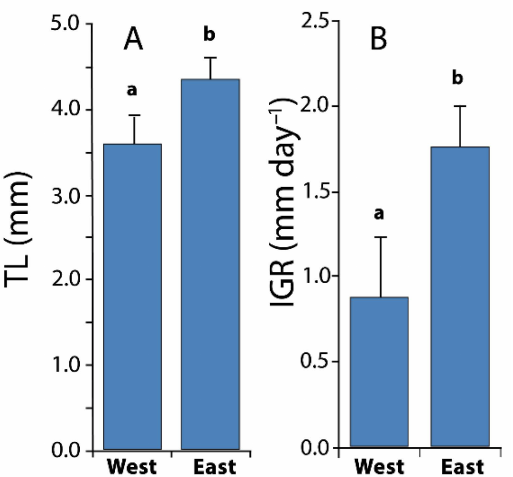
Figure 7 . Size and growth of recently hatched larvae from the western and the eastern spawning areas. ( A ) Total length (TL). ( B ) Individual growth rate (IGR). Lowercase letters (a,b) indicate statistically significant difference between the spawning areas (permutational t test, p -value < 0.05).